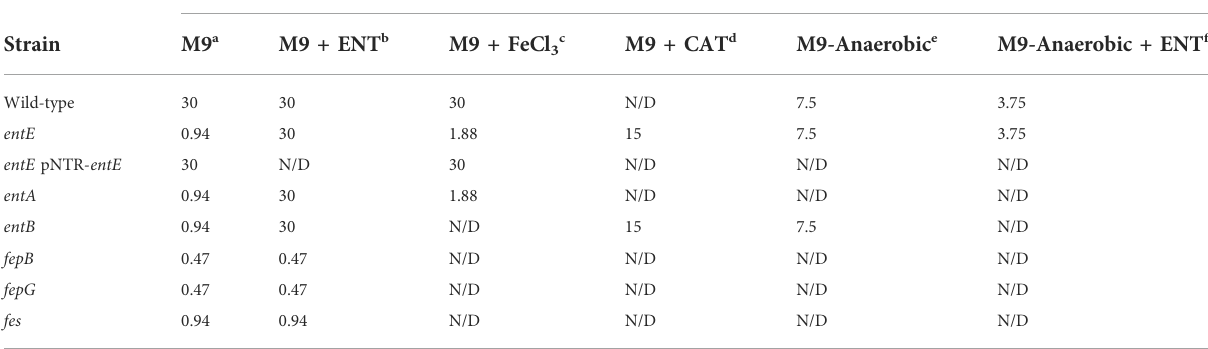
TABLE 2 MIC of CuSO 4 against selected bacterial strains with different additives and under anaerobic culture